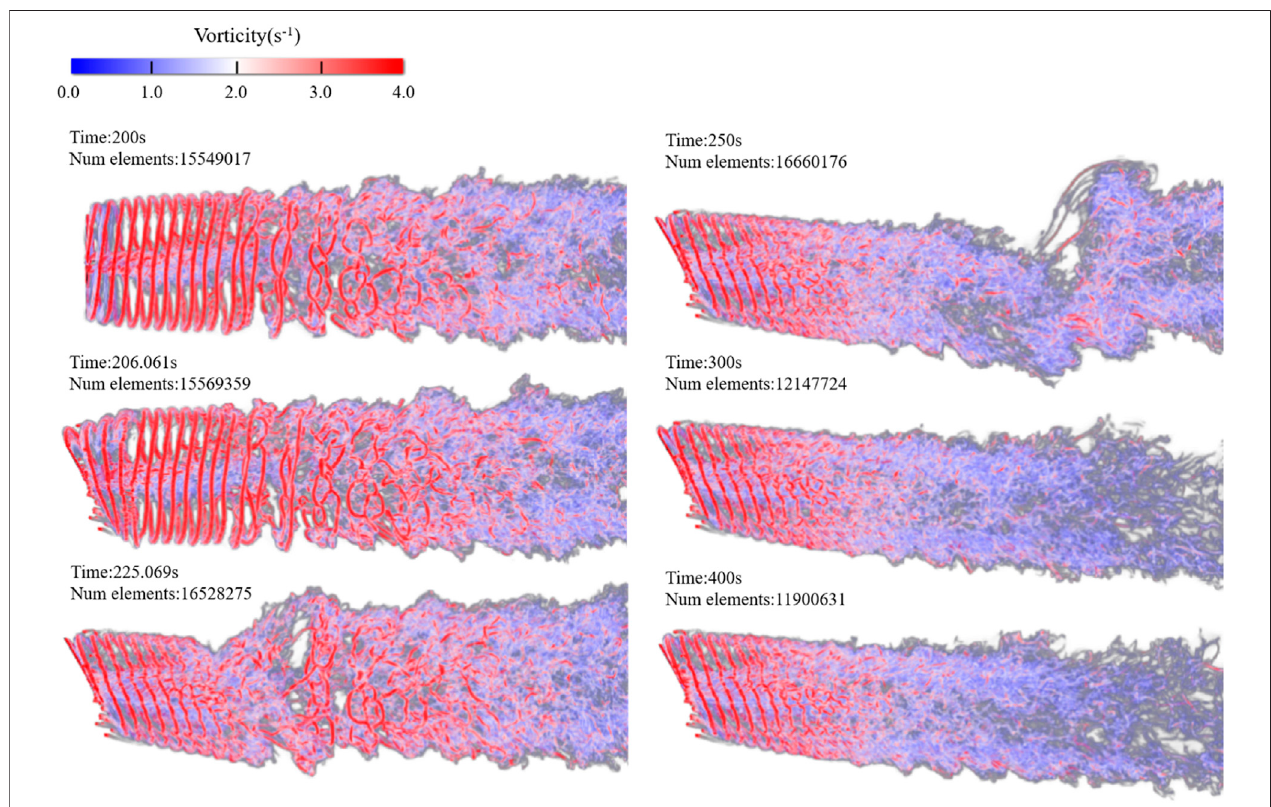
FIGURE 9 | Instantaneous vorticity contour of the horizontal section at the hub height under the rapid dynamic yaw.